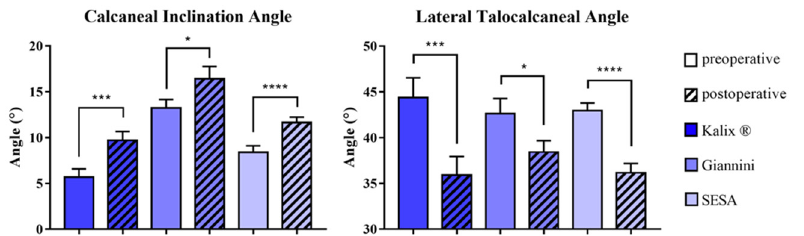
Figure 7. Comparison of pre- and postoperative radiographic foot alignment parameters subclassified by implant type. Calcaneal inclination angle (CIA) ( left ), Lateral talocalcaneal angle (LTCA) ( right ). ( μ ± SEM, Wilcoxon signed-rank test, * = p < 0.05, *** = p < 0.001, **** = p < 0.0001). SESA: subtalar extraarticular screw arthroereises.